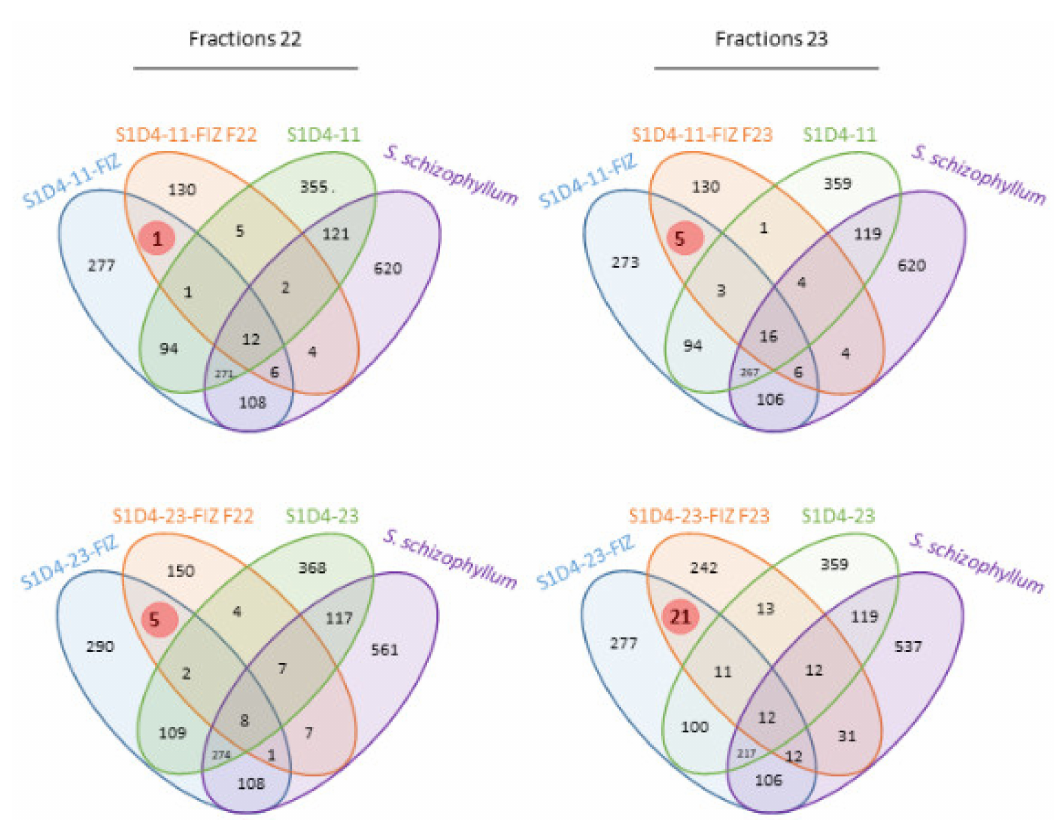
Figure 6. Identification of specific compounds in bioactive fractions. LC-MS spectra of fractions N ◦ 22 and N ◦ 23 (named S1D4-11-FIZ F22 and S1D4-23-FIZ F23, respectively) with anti- Bacillus activity were compared with single culture controls and with total extracts of SFIZ in DMSO, which also has similar activity. Compounds with potential activities (highlighted in red) are those at the intersection of the total SFIZ extract and in the fraction considered. The number of features found in each condition is indicated. Features were analyzed and compared with DEREPLICATOR+ in order to build the Venn